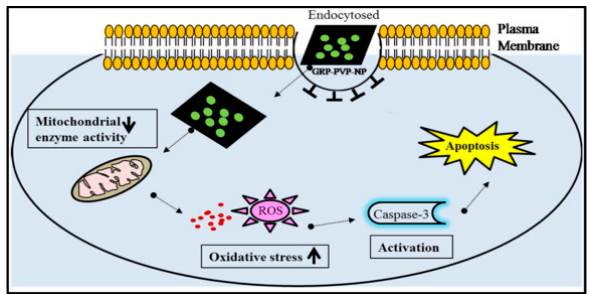
Figure 2. Schematic diagram of potential mechanism with graphene-poly(vinylpyrrolidone) nanoparticle composite (GRP-PVP-NP) induced cytotoxicity in cancer cells [15].